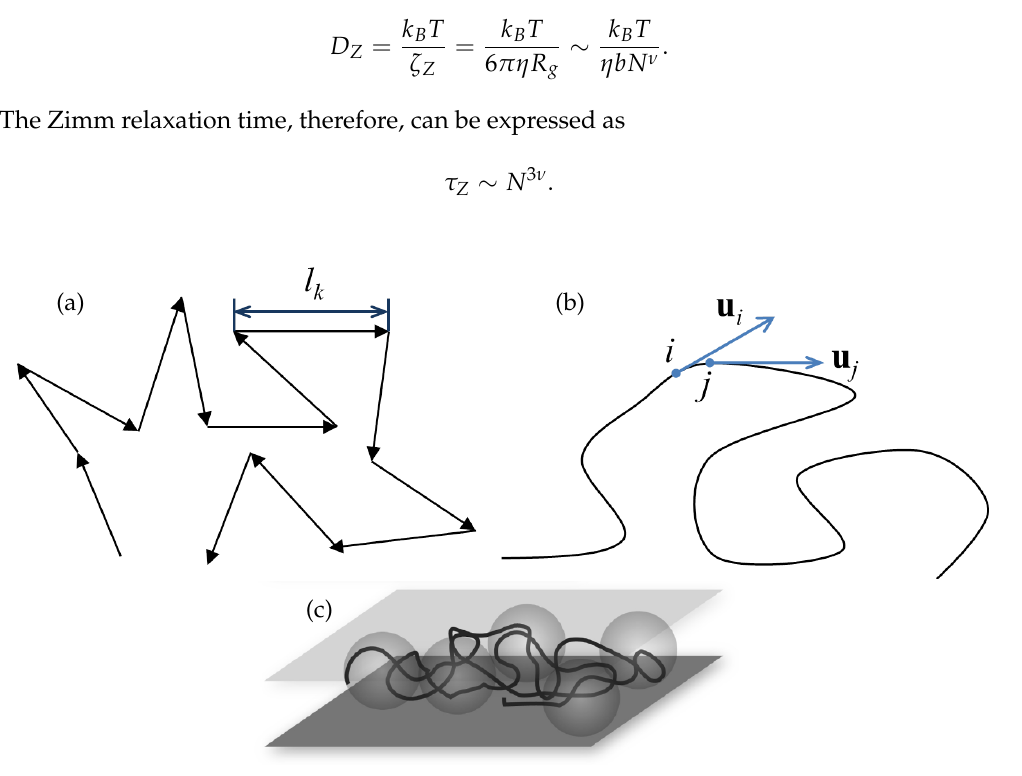
Figure 1. Different representations of a polymer. (a) Freely jointed chain model, where the black arrows represent the chain segments. (b) Worm-like chain model, where u i and u i are the tangents on the chain at points i and j . The tangent-tangent correlation along the chain is given by the relation l ij = exp , where l ij is the distance between the points i and j along the chain contour. (c) Chain under 2D confinement.